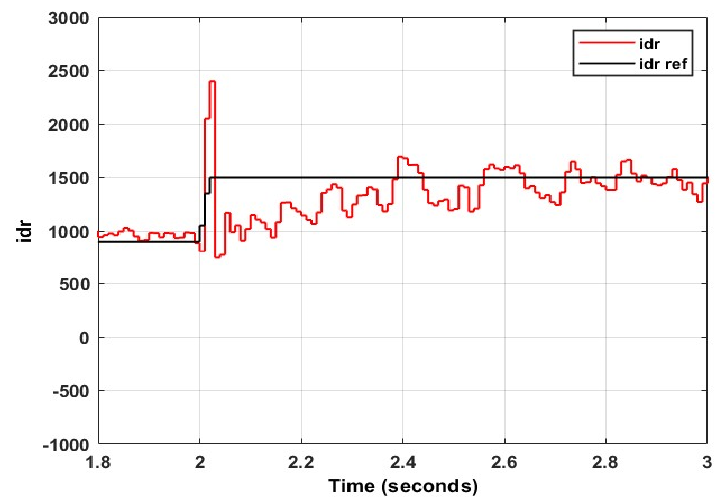
Figure 55. Rotor direct axis current ripple using LQR at 90% dip.